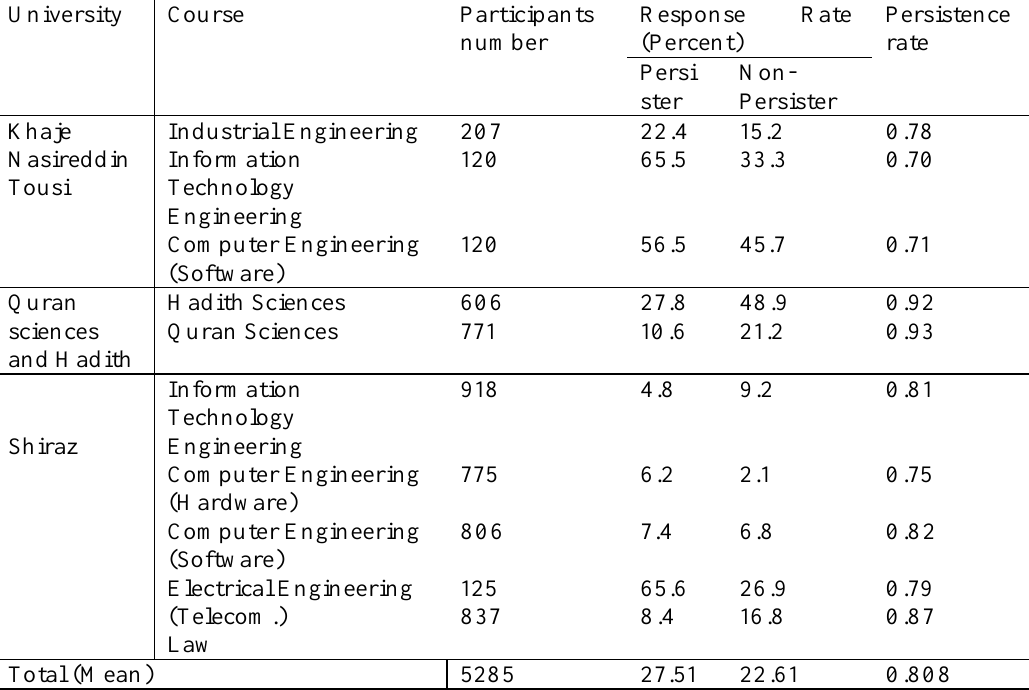
Statistical Population, Response and Persistence Rate of Each of the Online Courses